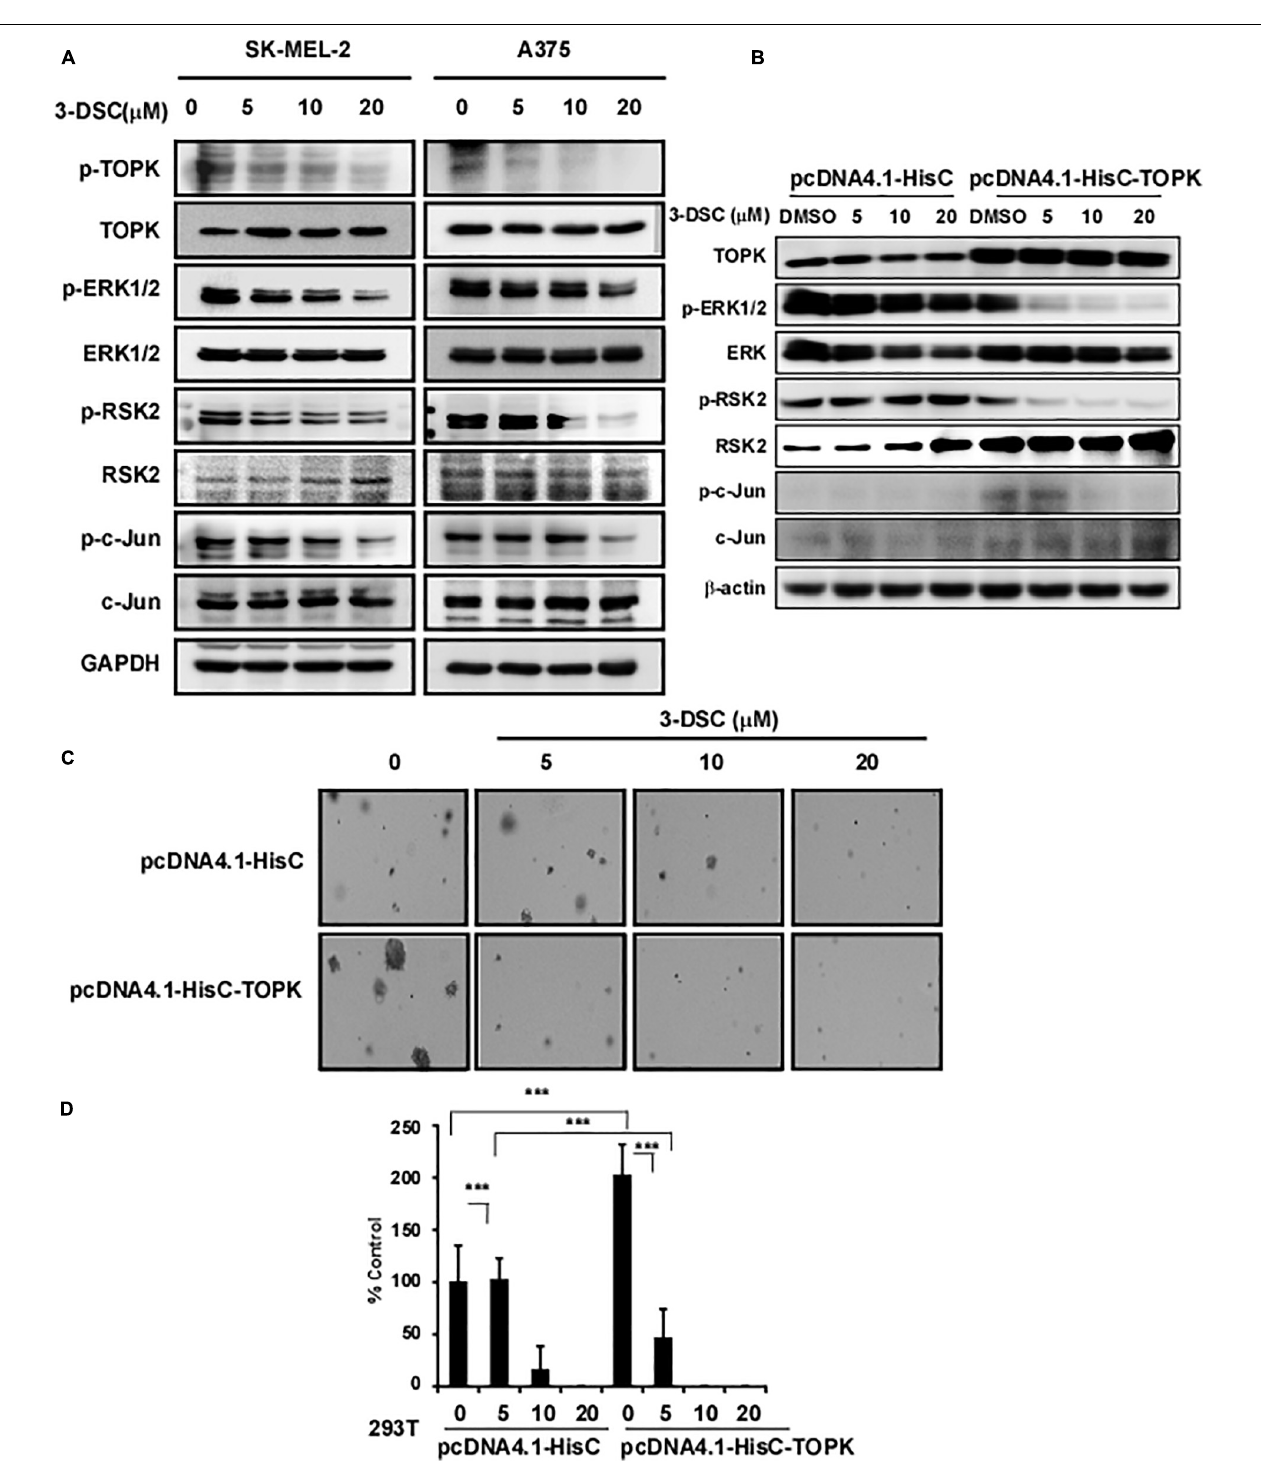
FIGURE 5 | 3-DSC inhibited TOPK signaling pathway in skin cancer cell lines. (A) p-TOPK, TOPK, and downstream effector protein expression after 3-DSC treatment. SK-MEL-2 and A375 cells were incubated with a culture medium with FBS and 3-DSC (5, 10, or 20 µ M) or without 3-DSC for 2 h, and cell lysates were harvested before analysis by western blot. (B) TOPK was overexpressed in HEK-293T cells using pcDNA4.1-HisC (control) and pcDNA4.1-HisC-TOPK before cells were treated with or without 3-DSC at various concentrations. (C) Effect of 3-DSC on anchorage-independent growth in HEK-293T cells expressing pcDNA4.1-HisC and pcDNA4.1-HisC-TOPK . TOPK over-expression increased colony number and size. (D) Quantification of colony number in panel (C) . Data are shown as mean ± SD values. *** p < 0.001.